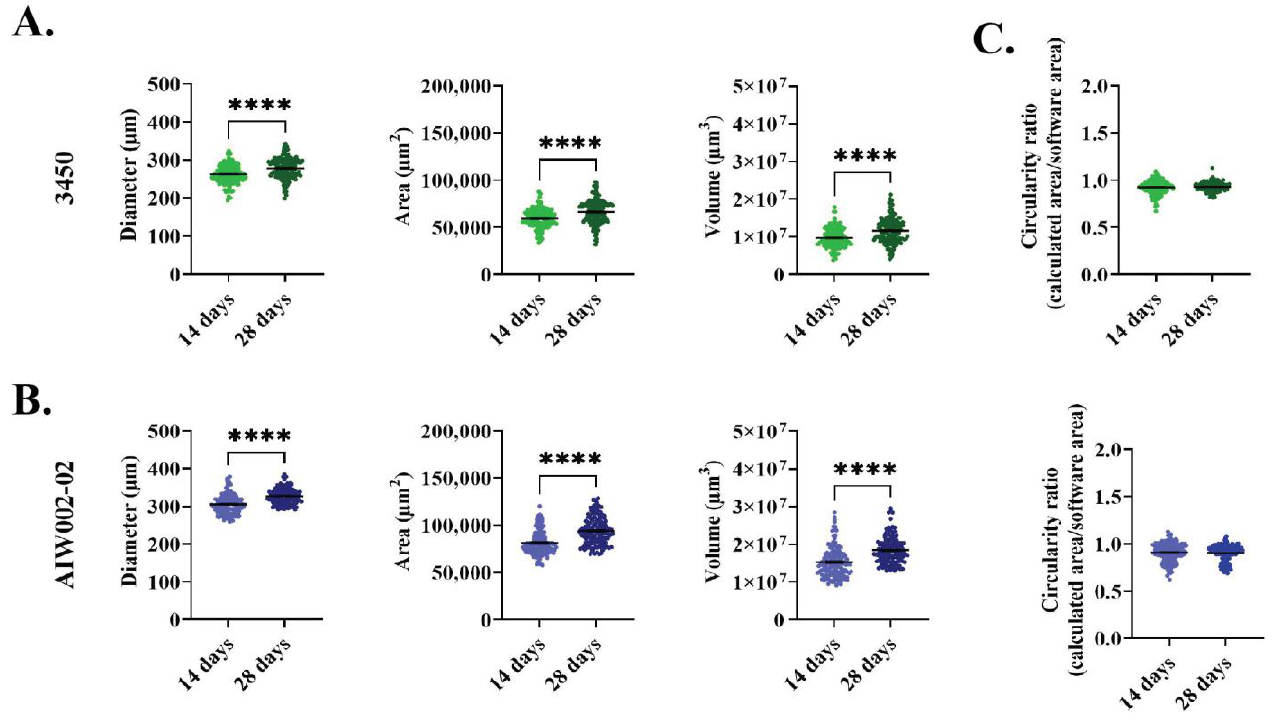
Figure 2. Size profile by a cell profiler pipeline. iPSC-derived MN spheroids from the ( A ) 3450 and ( B ) AIW002-02 control lines are consistently generated across different batches. They exhibit an increase in size over time as shown by diameter, area, and volume measurements. Scatter plots show the mean ± SEM; for each cell line, five MN spheroid batches coming from at least two iPSC-derived MNPCs batches induced through independent differentiation processes (AIW002-02 = 137 spheroids; 3450 = 142 spheroids). To ensure that MNPC passage number was not having any effect on MN spheroid formation, we used the MNPCs at passage number 2 to 4. Significance was determined by a paired t -student. **** p ≤ 0.0001. ( C ) Additionally, MN spheroids display a circular shape with bulges appearing occasionally but without disturbing the circular morphology, as shown by the circularity ratio (0 = not circular; 1 = perfect circle).